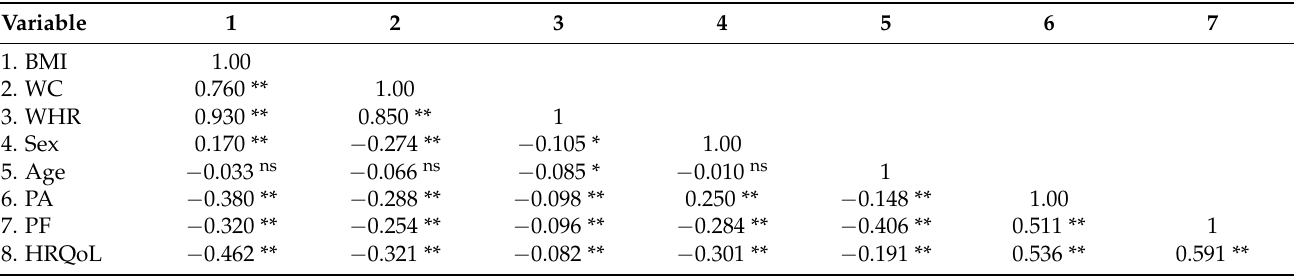
Table 2. Correlation matrix coefficients between the studied